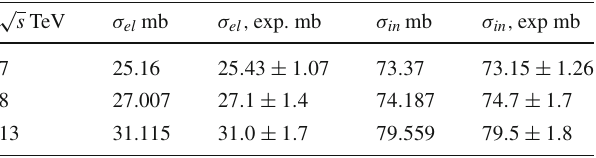
Table 3 The total cross section of proton–proton elastic scattering σ el and inelastic scattering σ in . The experimental data are taken from [1,3, 5] for 7, 8 and 13 TeV, respectively √